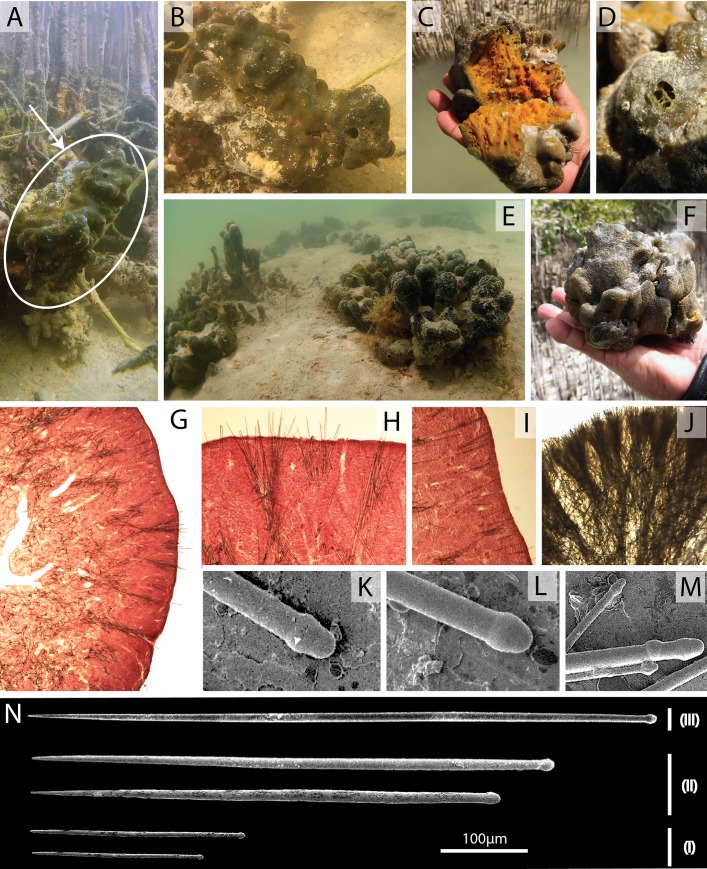
Suberites luna
sp. nov., morphology, skeleton and spiculation: (A, B)
growing on mangrove pneumatophores in the riparian zone; (C) just
collected and cut; (D) large compound oscule; (E) large specimens
close to seagrass; (F) specimen just collected. Slides of fresh
specimens, (G) cross section of choanosomal skeleton; (H) plumose
choanosomal skeleton in cross section, (I) palisade of subtylostyles
in the ectosome. Slide in cross section of dried specimen showing
plumose choanosomal skeleton (J). Electronic Microscopy, (K, L, M)
showing different head shapes of the subtylostyles; (N) the
subtylostyles types (I), (II) and (III).